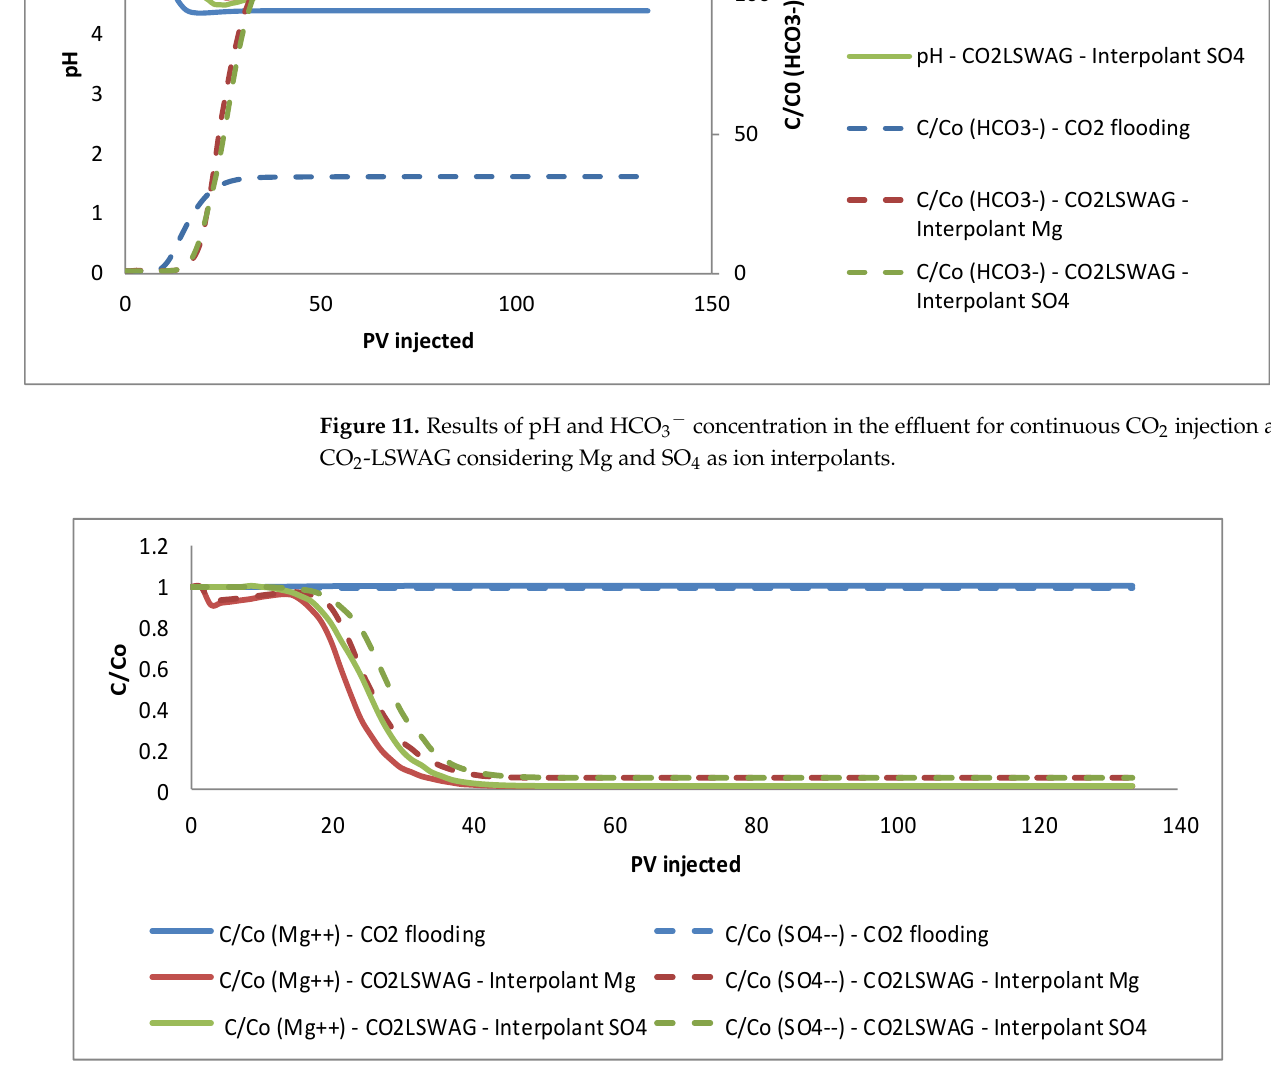
Figure 11. Results of pH and HCO 3 − concentration in the effluent for continuous CO 2 injection and CO 2 -LSWAG considering Mg and SO 4 as ion interpolants.